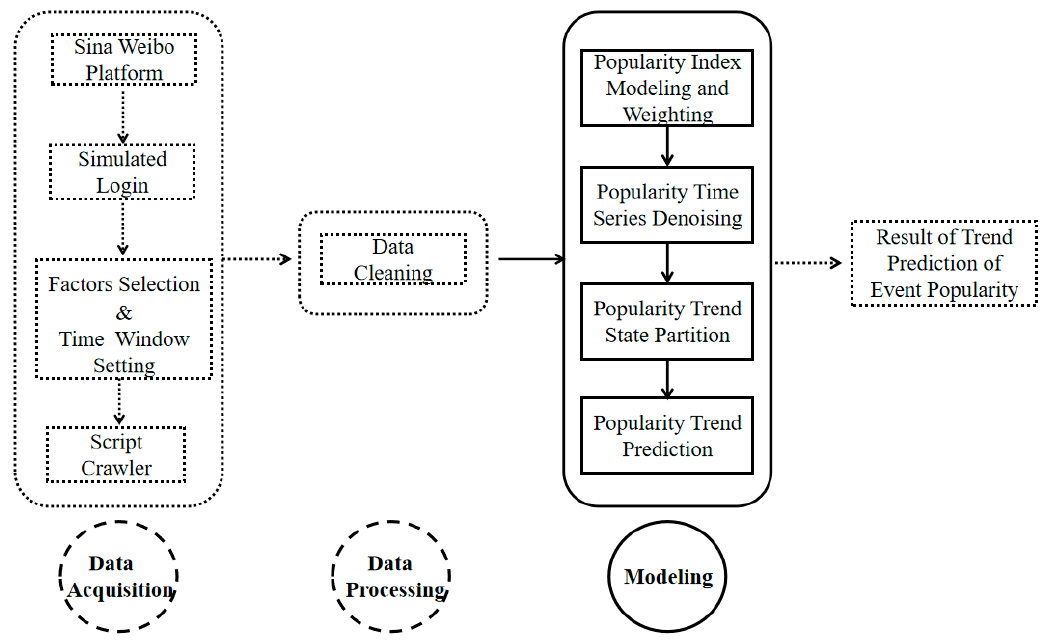
Figure 1. System framework of the event popularity trend prediction from Weibo platform.